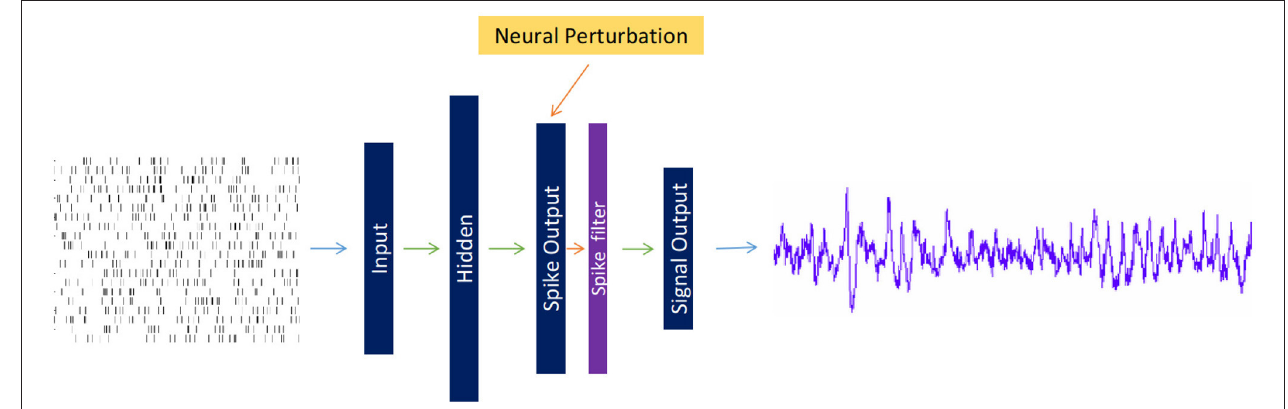
FIGURE 1 | Depiction of a three-layered feedforward spiking network mapping a random spike train to an electroencephalography (EEG) signal with additional neural perturbation layer of Poisson neurons distorting the information of Spike Output layer. The spike train from the Spike Output layer is converted to a smoothed signal via a double exponential spike filter, which is then transformed to an EEG signal. The number of nodes in each layer varies depending on the task for best fit.